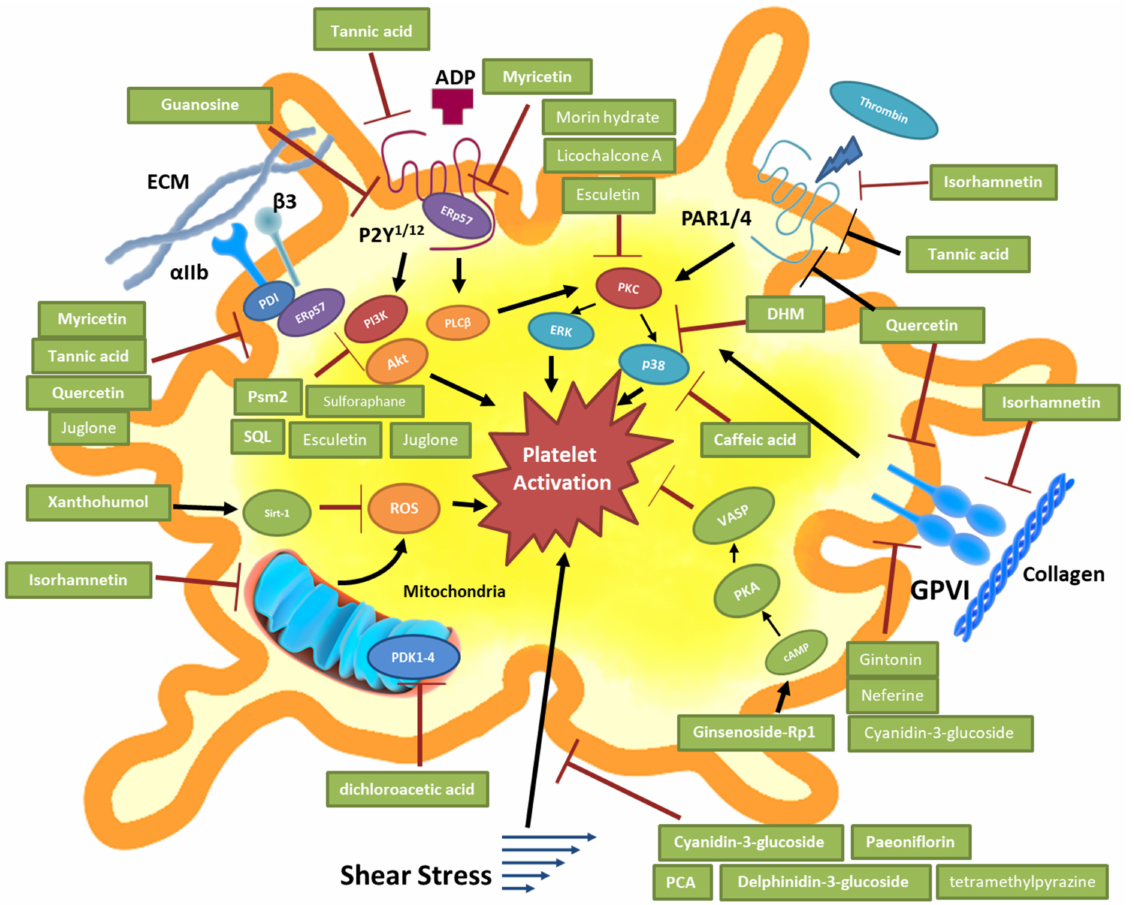
Figure 1. Antiplatelet targets of bioactive compounds without bleeding risk. In red lines: inhibition, black arrows: activation. DHM: dihydromyricetin, PCA: protocatechuic acid. SQL: tripeptide